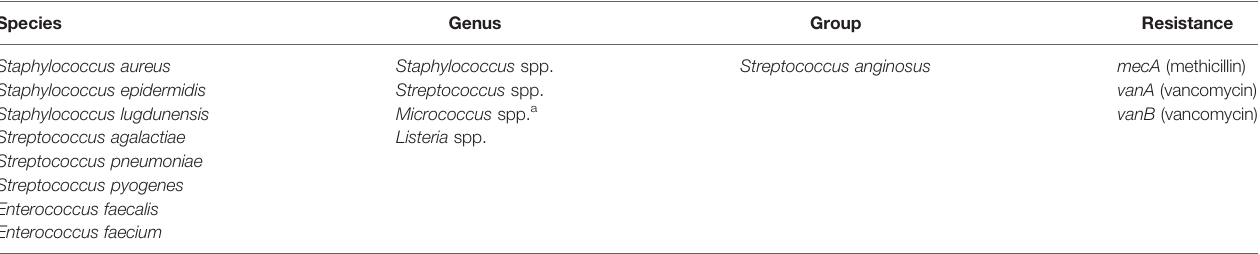
TABLE 1 | Targets included in the VERIGENE Gram-Positive Blood Culture